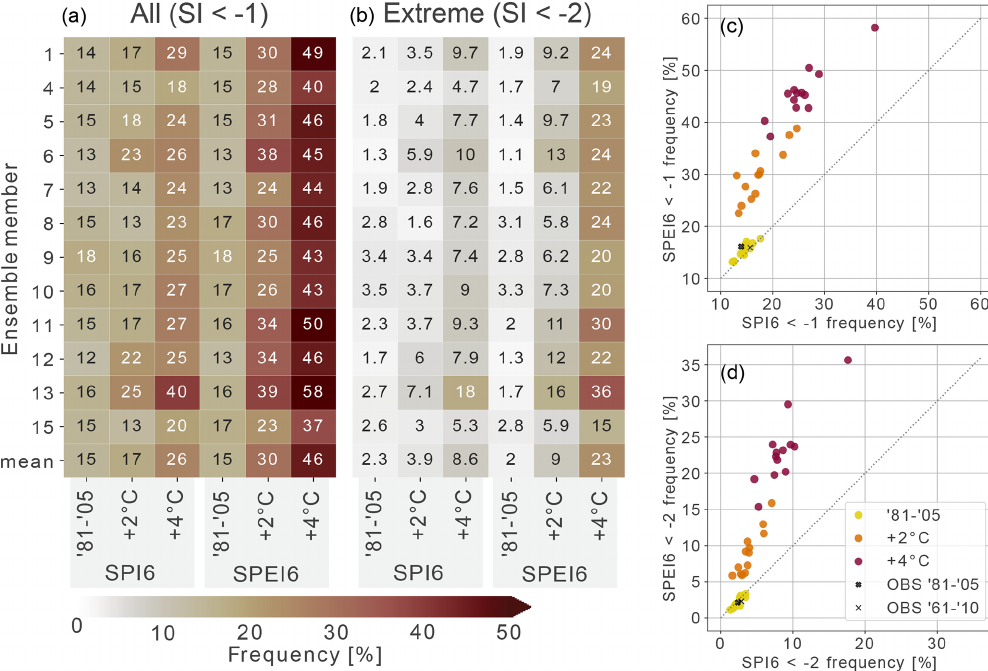
treme drought frequencies are 0.15 and 0.023